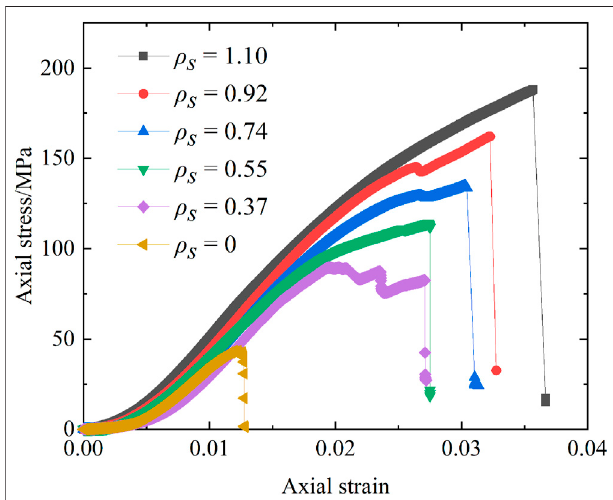
FIGURE 5 | Axial-stress – axial-strain curves under different con fi ning stiffness ratios.